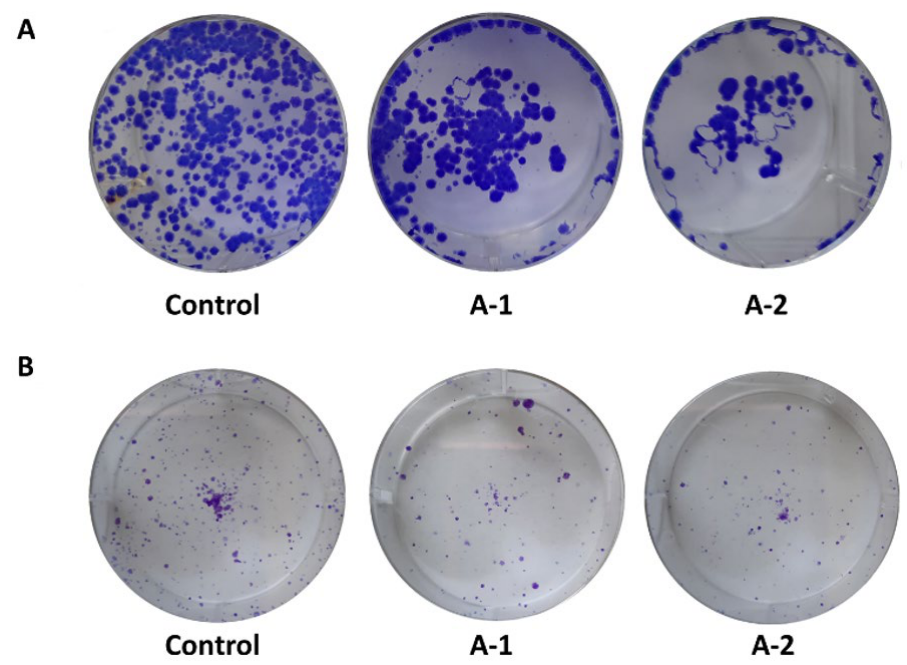
Figure 5. Representative colony formation images of: ( A ) HCT-116 cancer cells and ( B ) MCF-7 cancer cells, after 72 h treatment with compounds A-1 and A-2 .